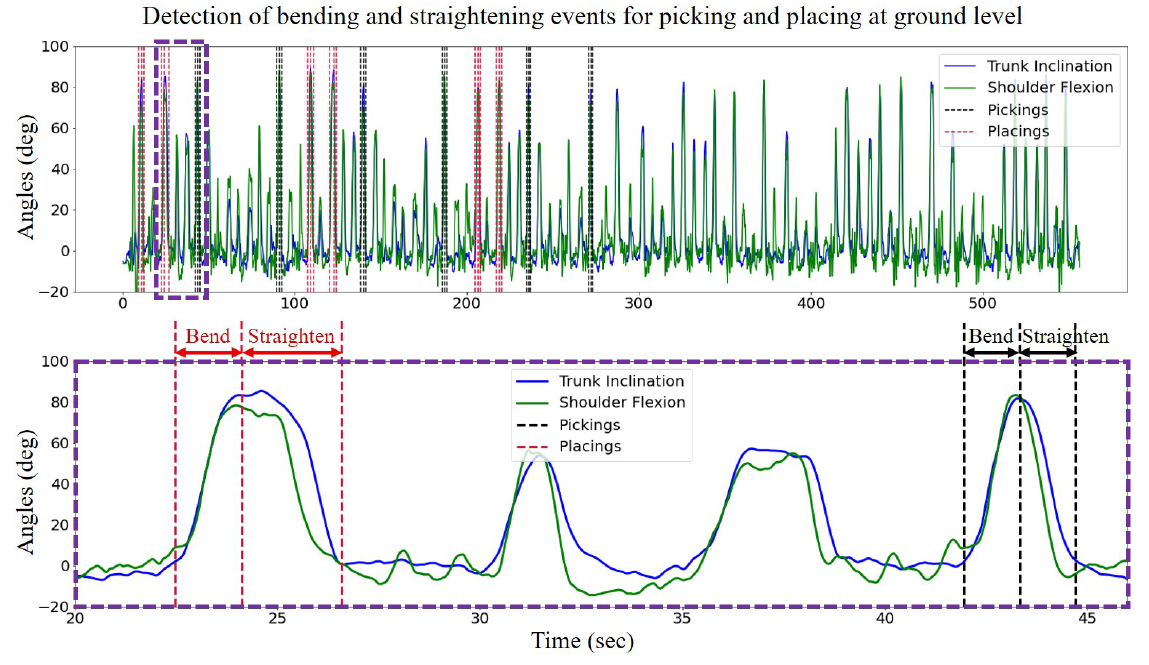
Figure 3. Automated segmentation of six sets of the four events at the ground level in one representative session. Every three consecutive red dashed lines mark two intervals of bending and straightening during placings, and the black dashed lines construct the bending and straightening intervals during the